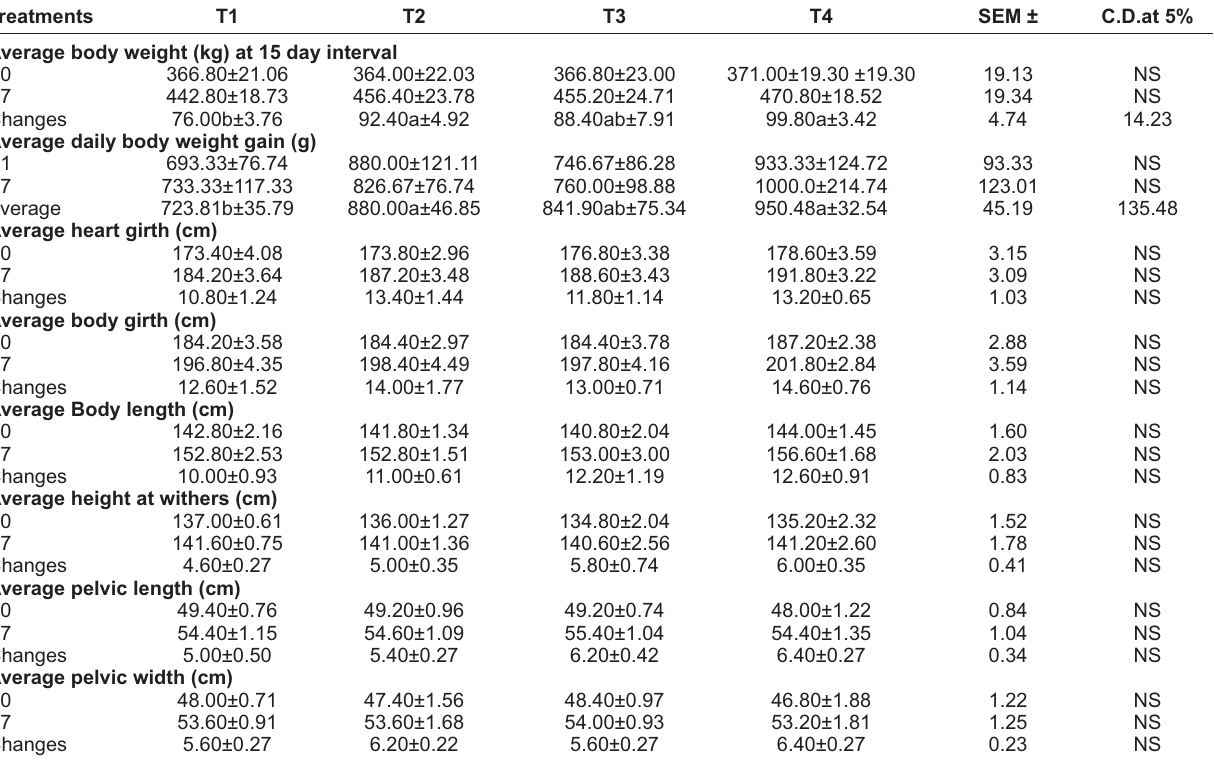
Table-2. Body weight and biometric changes of experimental heifers (n=5). Treatments